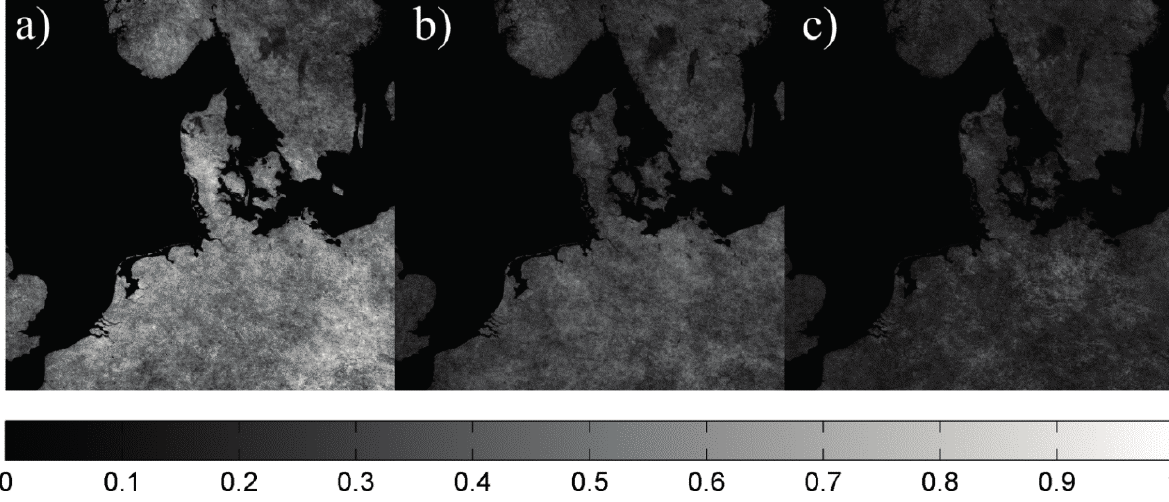
Figure 4. Standard deviation for MAST of 10 randomly sets of scenes equivalent to ( a ) one, ( b ) two, and ( c ) four years of data in Kelvin for tile